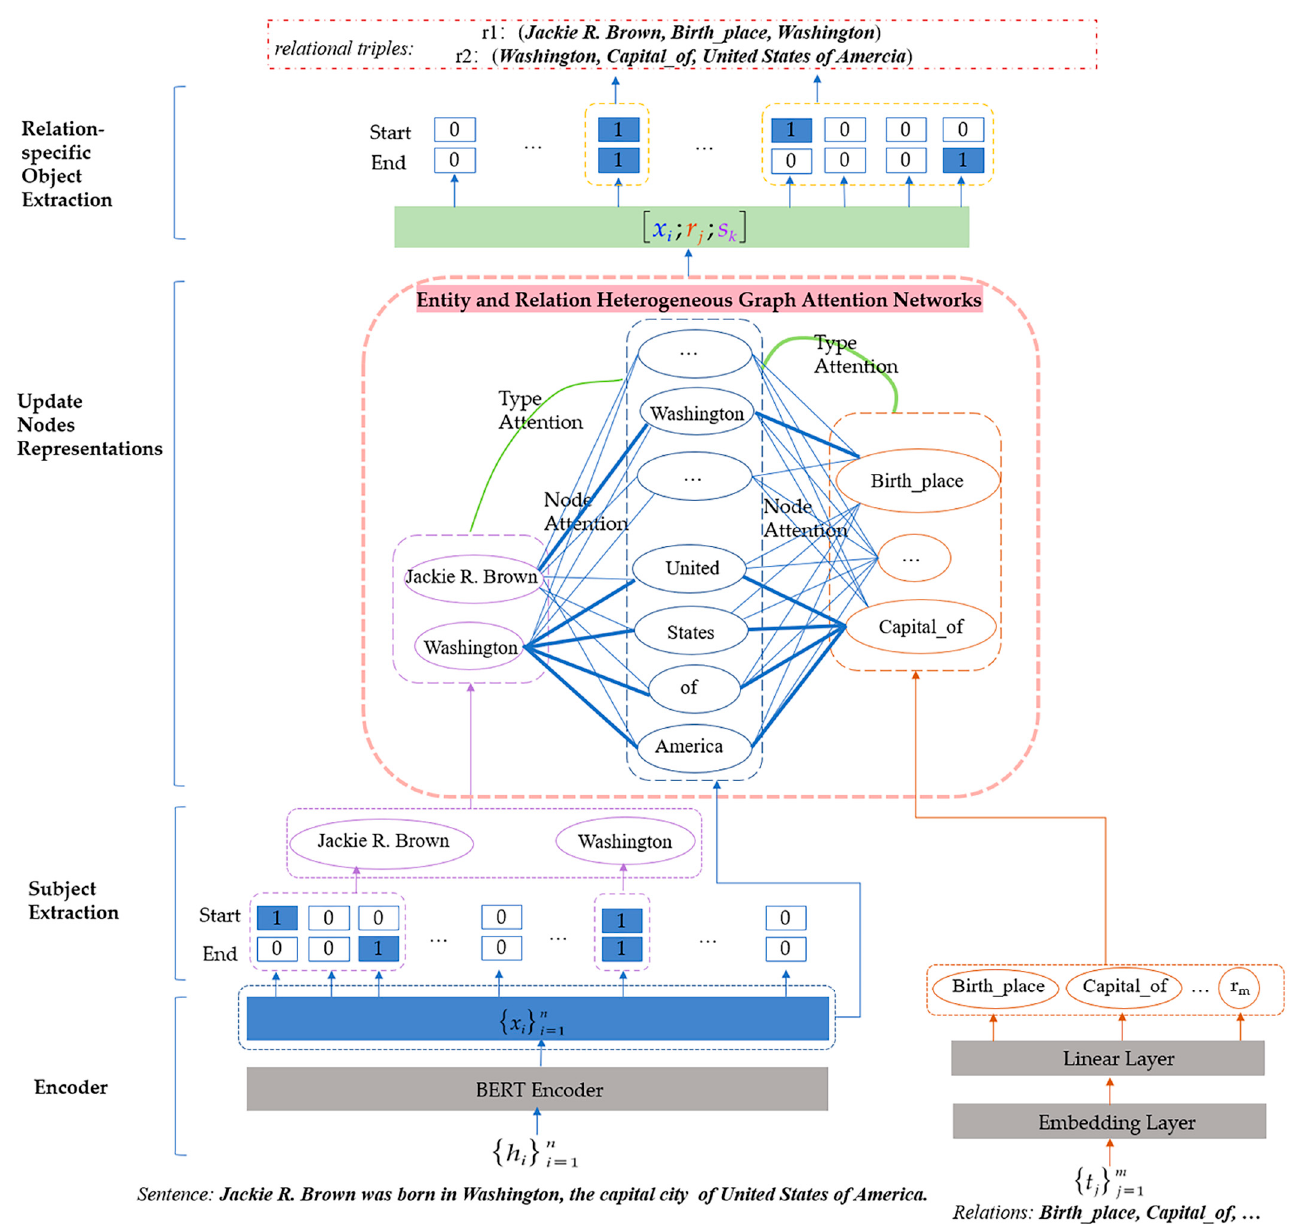
Figure 1. Architecture of our proposed ERHGA for joint entity and relation extraction tasks.